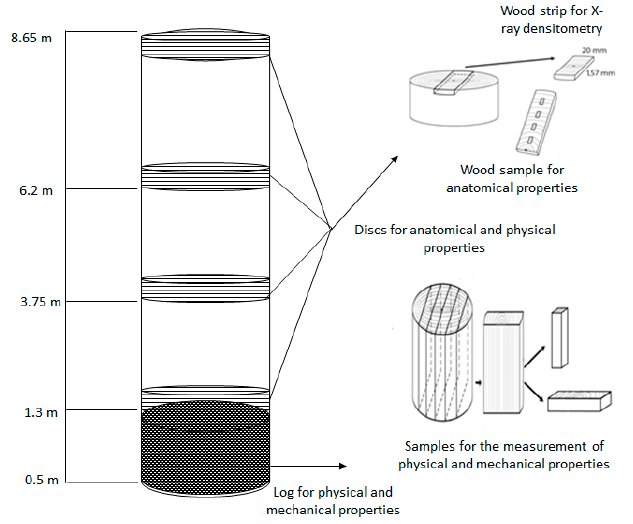
Figure 2. Sampling methods for discs and logs and test samples for the anatomical, physical and mechanical properties of wood. mechanical properties of